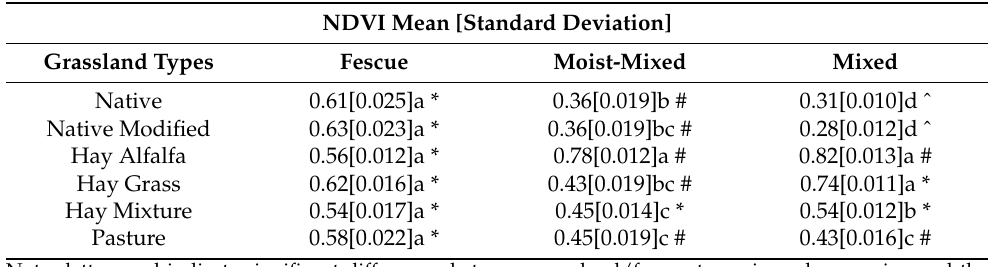
Table 2. ANOVA test results for NDVI mean and standard deviation for the grassland/forage land classes in the three